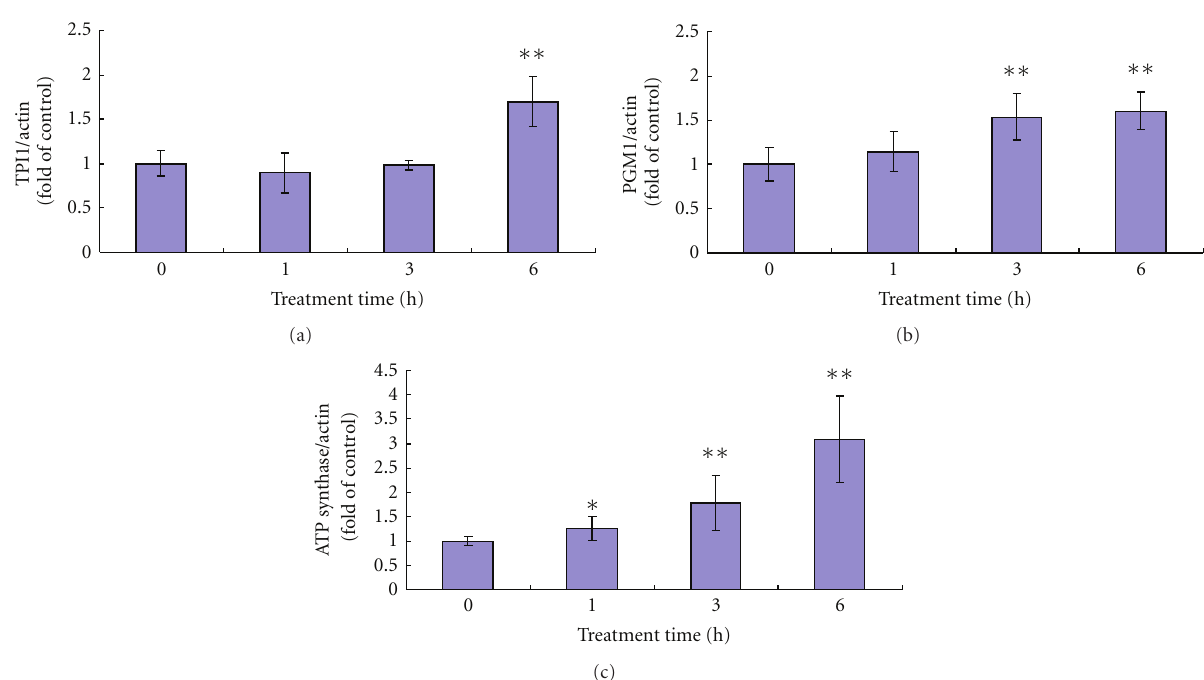
Figure 1: E ff ect of C. monspeliensis extract on the expression of TPI (a), PGM (b), and ATP synthase (c) mRNA by Caco-2 cells. β -actin was used as a house-keeping gene. The mRNA expression of TPI, PGM, and ATP synthase was normalized by β -actin mRNA expression. Each bar represents the mean ± SD ( n = 3). ∗ P < 0 . 05, ∗∗ P < 0 . 01 compared to the control as determined by the t -test.